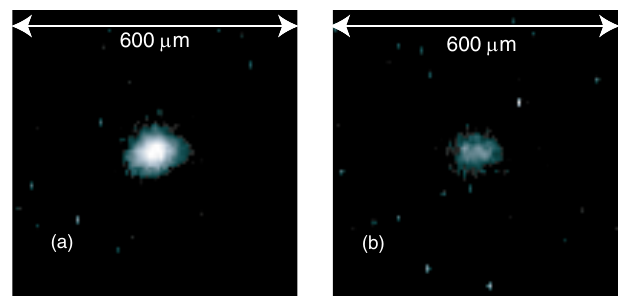
FIG. 30. (Color) CCD images of the (a) uncompressed and (b) compressed electron beam spots at the interaction point.